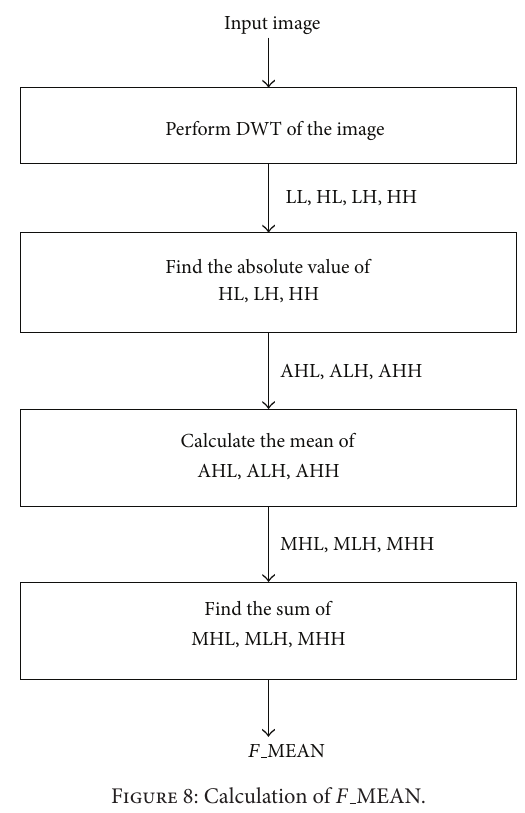
Figure 8: Calculation of F